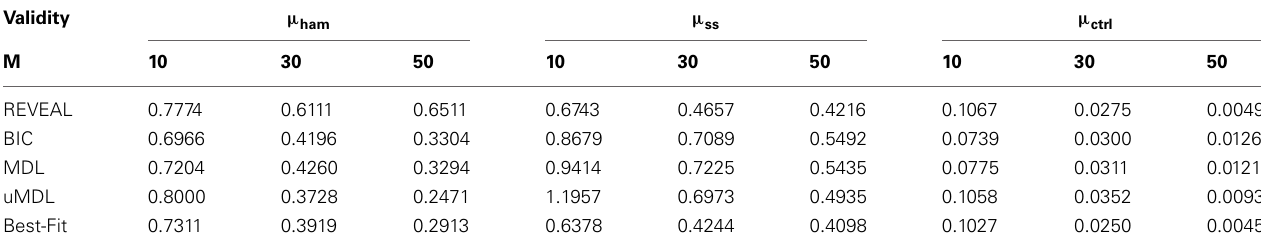
Table 1 | The comparison of network inference algorithms (REVEAL, BIC, MDL, uMDL, and Best-Fit) with M different number of observed state